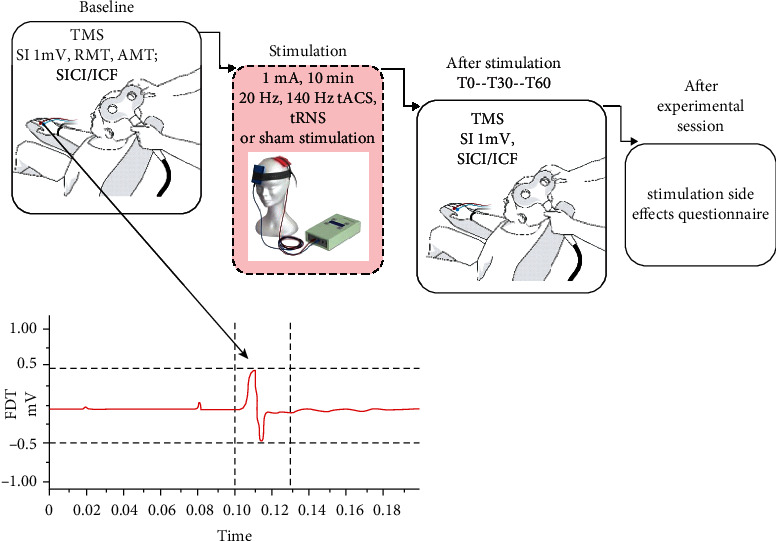
Design of the study. The figure illustrates the procedure for each experimental session. In the beginning of each session, 20 baseline single-pulse MEPs of SI 1 mV amplitude, RMT, AMT, and SICI/ICF were recorded. Afterwards, 1 mA tRNS, 20 Hz tACS, 140 Hz tACS, or sham stimulation was applied over the left primary motor cortex for 10 minutes, and then the SI 1 mV, SICI/ICF were recorded again directly as well as 30 and 60 minutes after stimulation (T0-T60). After finishing each experimental session, the participant was asked to complete a stimulation side effects questionnaire.